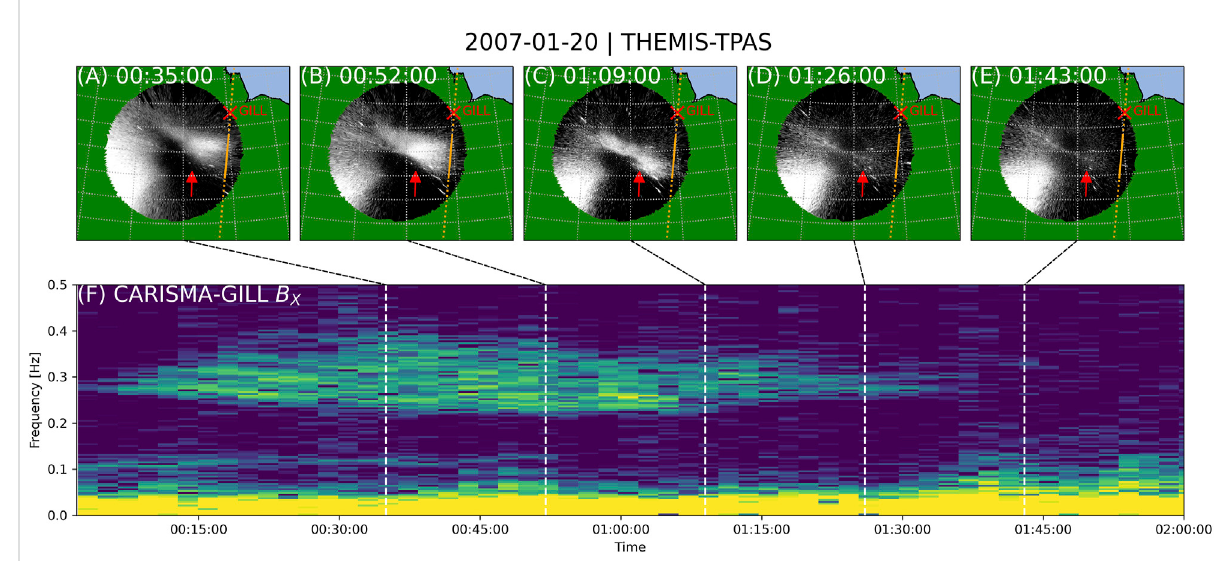
FIGURE 1 Select ASI images and magnetic fi eld spectrum from the fi rst 2 hours on 2007 – 01-20. (A – E) show select THEMIS ASI images from The Pas (TPAS). The intensity bounds are identical between the panels. Light pollution from twilight and other terrestrial sources is in the lower-left corner (south-west).Theredarrowspointtotheprotonaurorathattheimagerobservedin (A – C) .TheredXshowsthelocationoftheASIandMSPatGillam. The dotted orange line shows the GILL-MSP fi eld of view, with the solid orange highlighting the 62 ° − 65 ° magnetic latitudes. (F) shows the B X component of the magnetic fi eld variations observed by a CARISMA magnetometer in Gillam. The proton aurora coincided with the EMIC wave in (A – C) , after which the magnetic wave power and proton aurora simultaneously faded in (D,E)